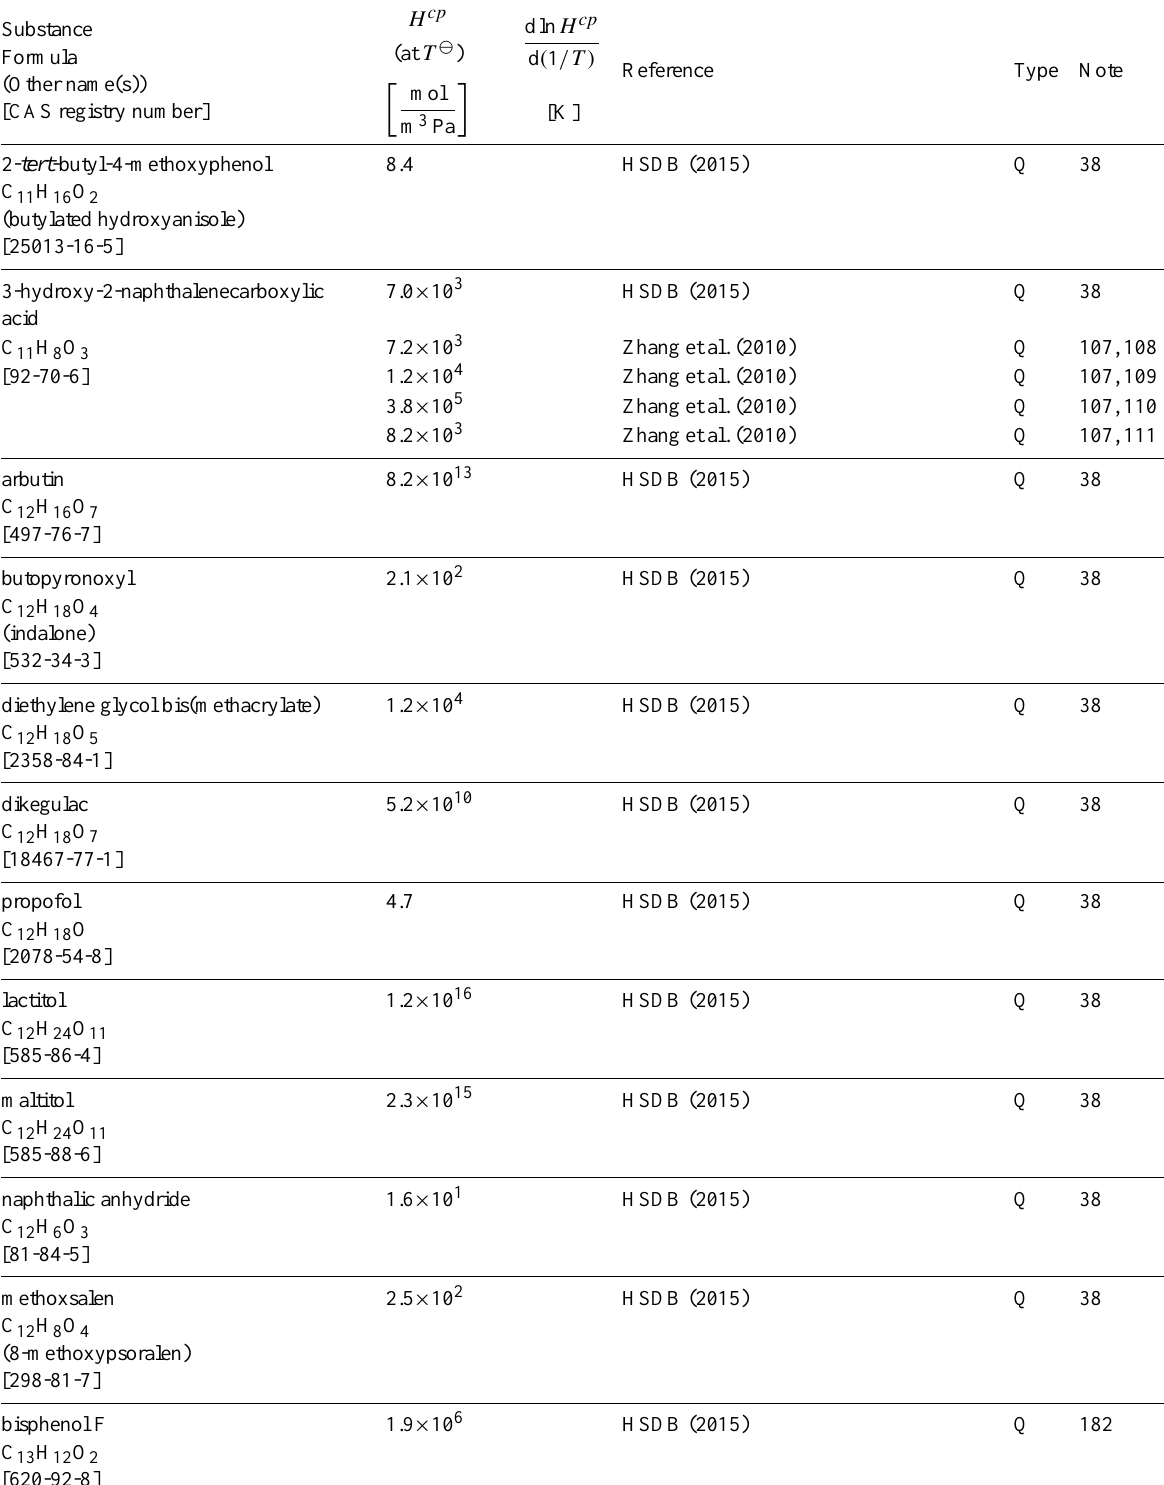
Table 6: Henry’s law constants for water as solvent